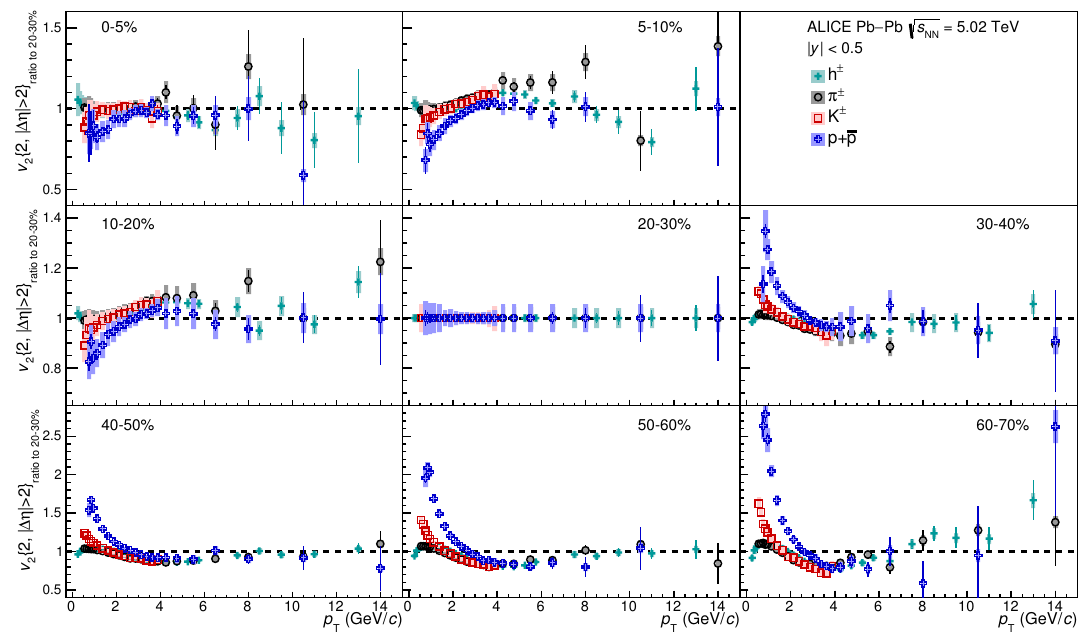
Figure 15 . (Colour online) Centrality dependence of v 2 ( p T ) inclusive charged particles [44]. Statistical and systematic uncertainties are shown as bars and boxes, respectively.